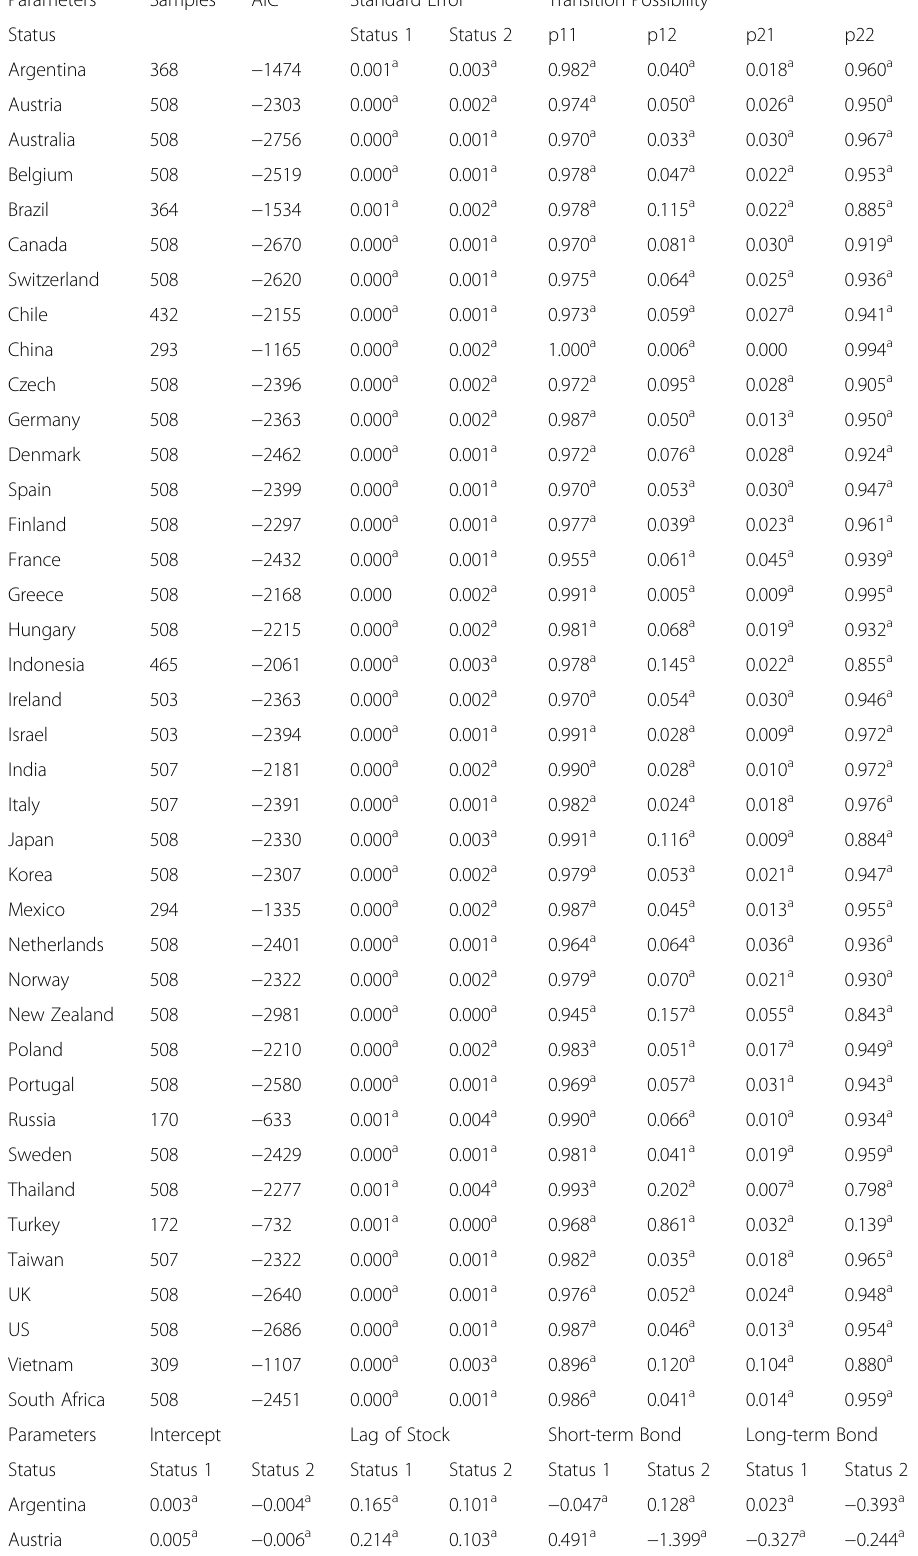
Table 3 Detailed results of markov switching